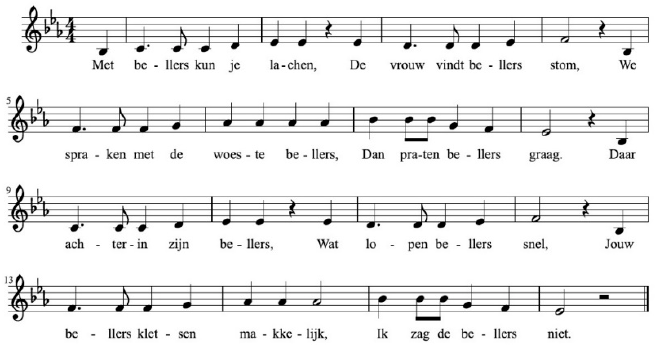
Figure 2. Example of score for the song that was used for target word ‘bellers’. Table 2. The 20 target word pairs (English translation in parentheses), and songs that were the base for the melody of that specific word pair (language of lyrics of original song in parentheses).